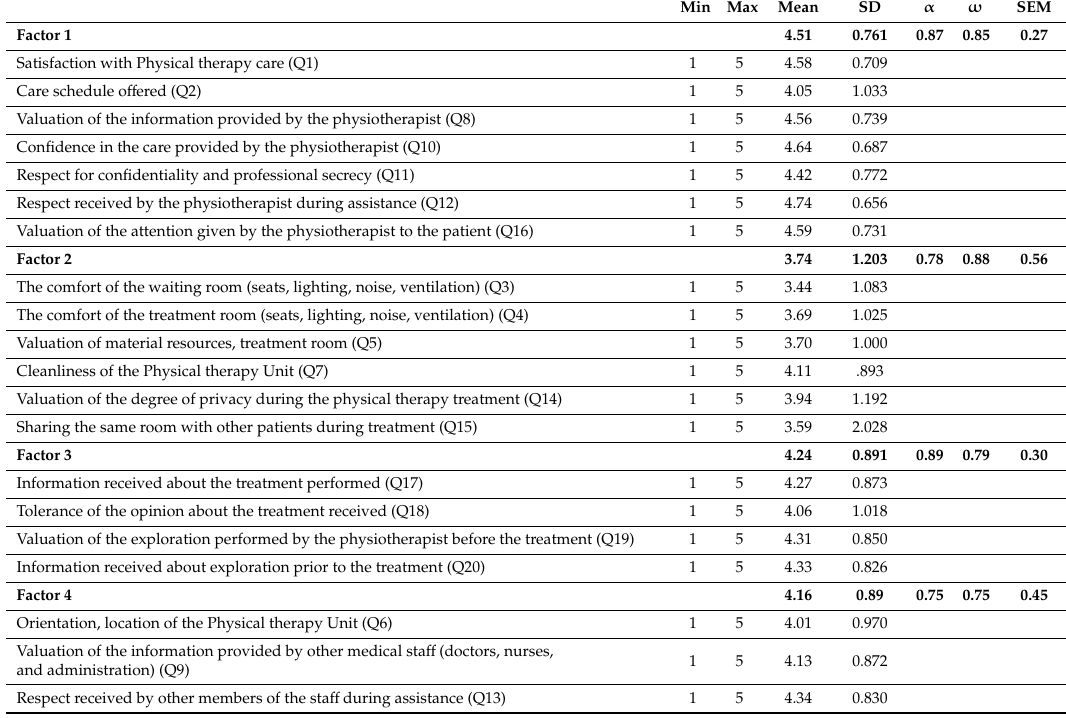
Table 3. Mean values, standard deviation, minimum and maximum of each item of the survey and metric properties of the four factors.